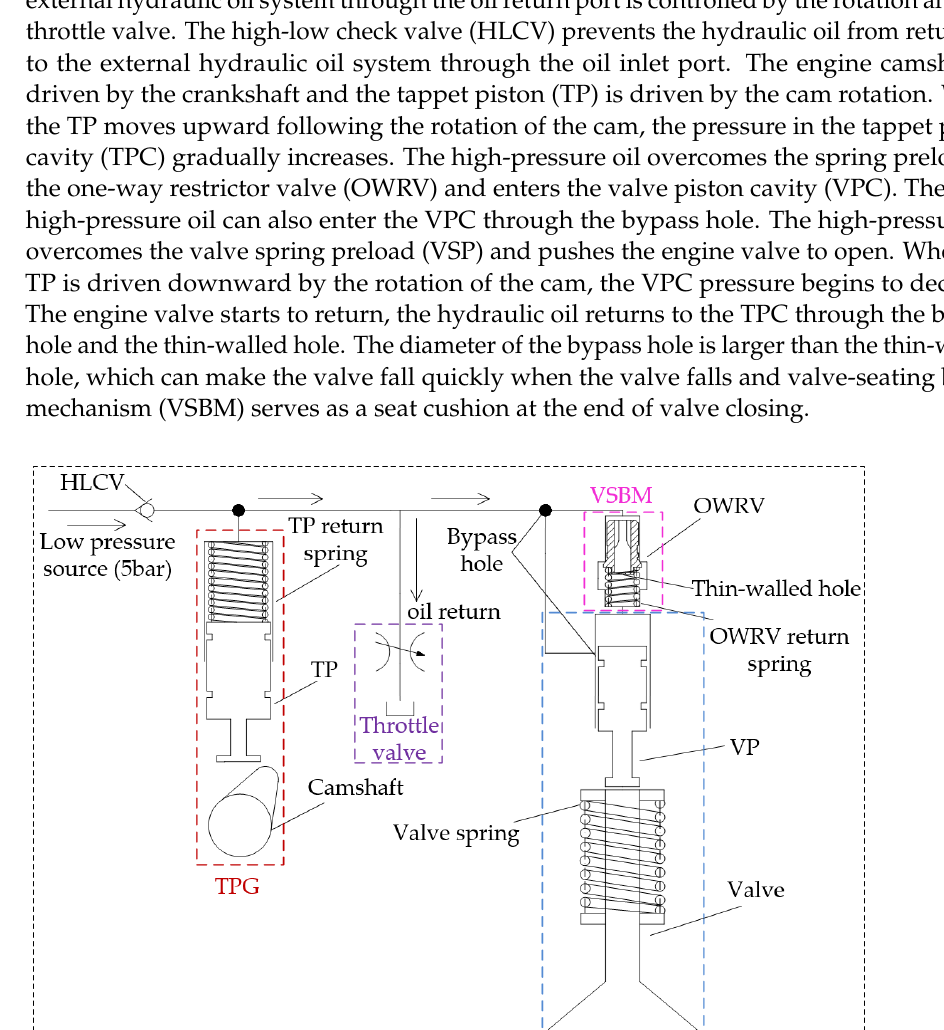
Table 1. The diesel engine parameters.